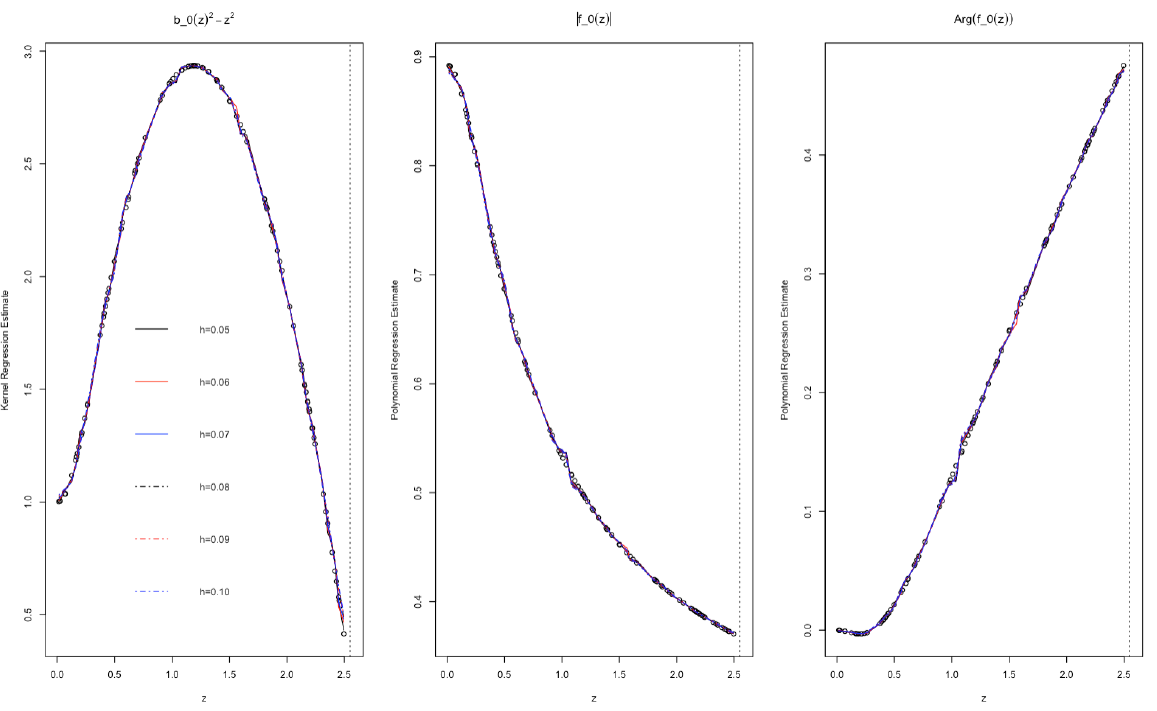
Figure 4. The estimates of critical collapse functions based on a kernel regression method with bandwidth parameters h = { 0.05,0.06,0.07,0.08,0.09,0.10 } in elliptic case based on a training sample of size n =